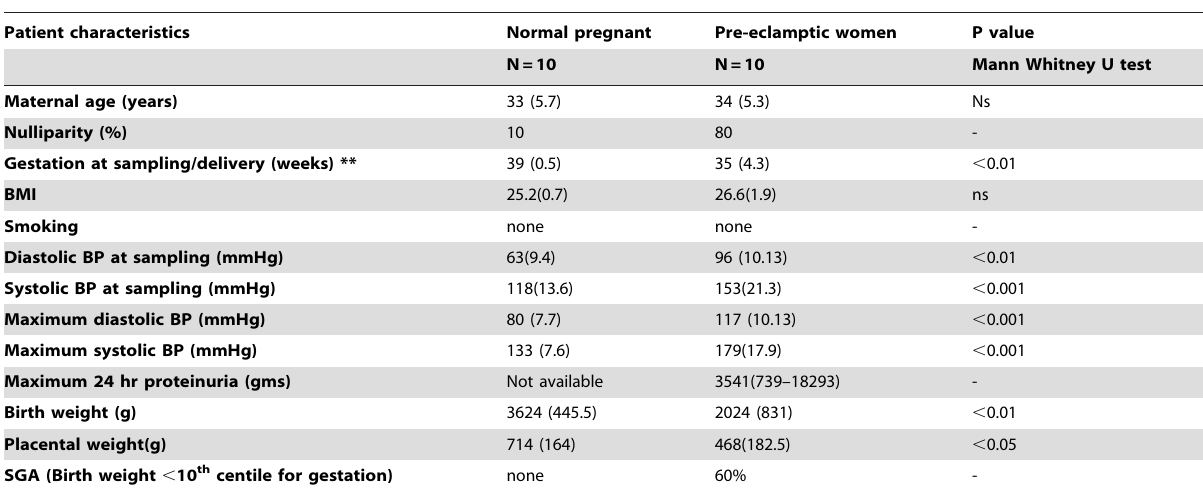
Table 2. Elective Caesarean Section